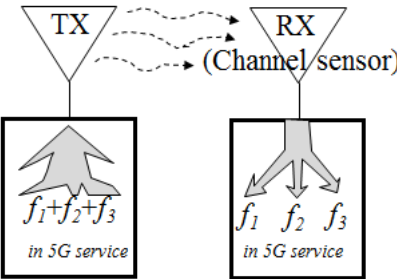
Figure 1. Three channel signals combined in the TX antenna will be split and selected to their corresponding bands in the RX antenna system.